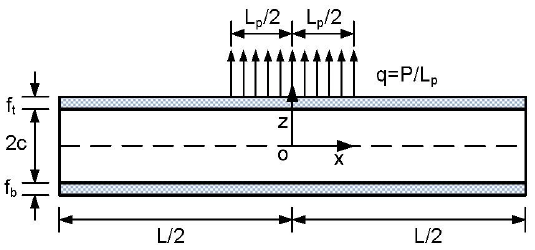
Figure 1. Sketch of a sandwich panel with a soft core.